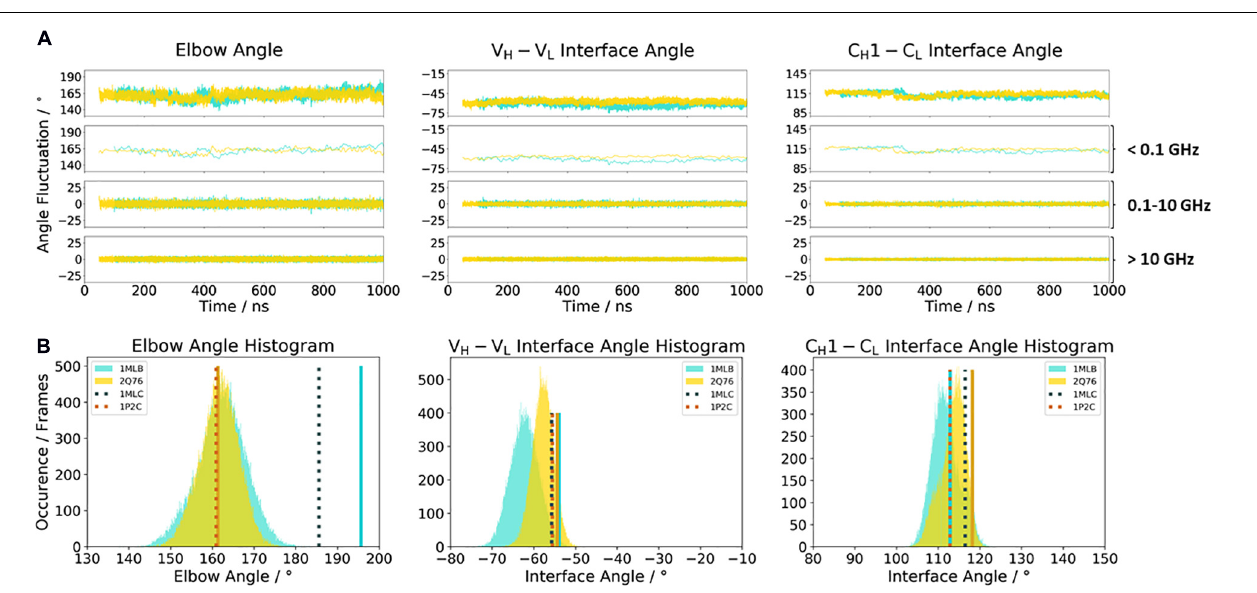
( Figure 5A ). This rigidification can also be confirmed by the narrower histograms of the matured F10.6.6 Fab illustrated in Figure 5B . In agreement with previous results, the FFT of both the D44.1 and F10.6.6 antibodies shows that also in this example